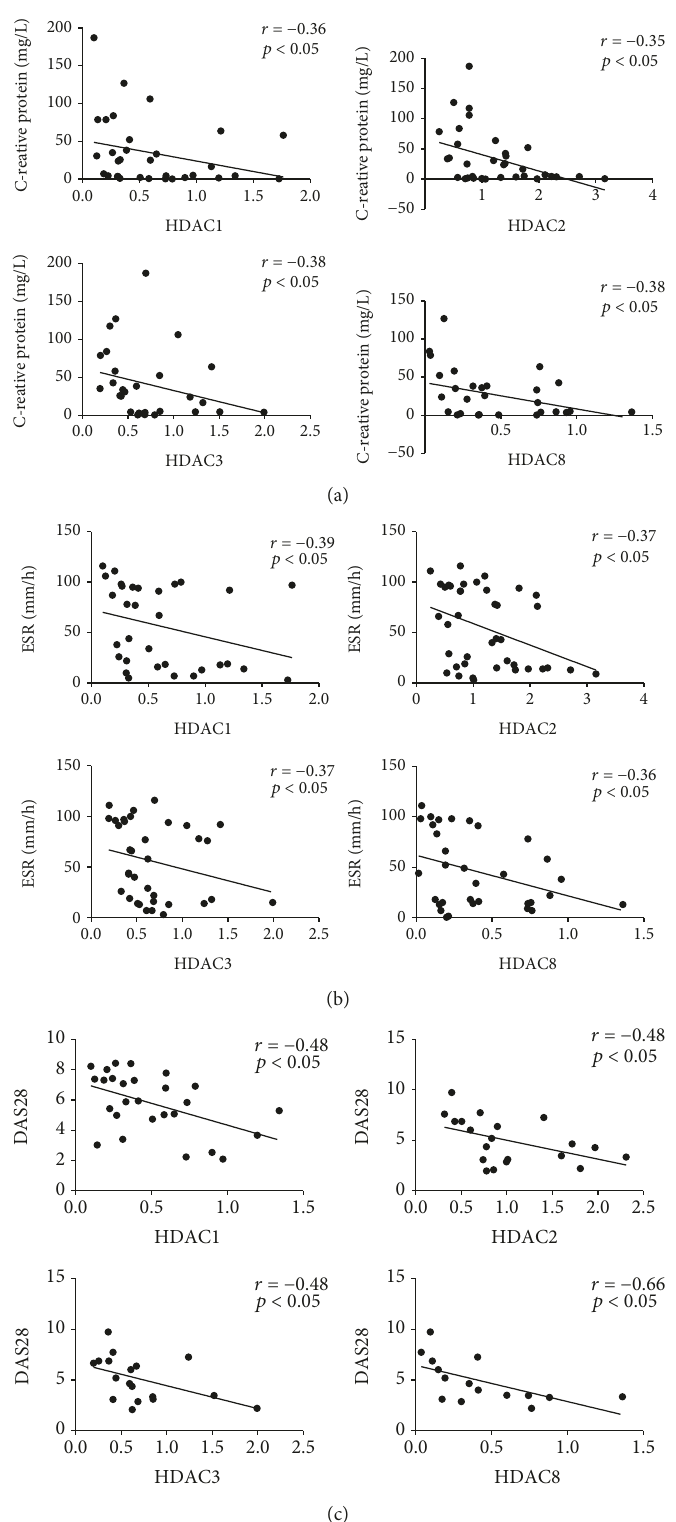
Figure 2: The mRNA expression of class I HDACs negatively correlates with CRP, ESR, and DAS28 levels. The correlations between the mRNA expression levels of class I HDACs and RA disease characteristics were determined by using the Spearman test and are shown for (a) C-reactive protein (CRP), (b) erythrocyte sedimentation rate (ESR), and (c) disease activity score